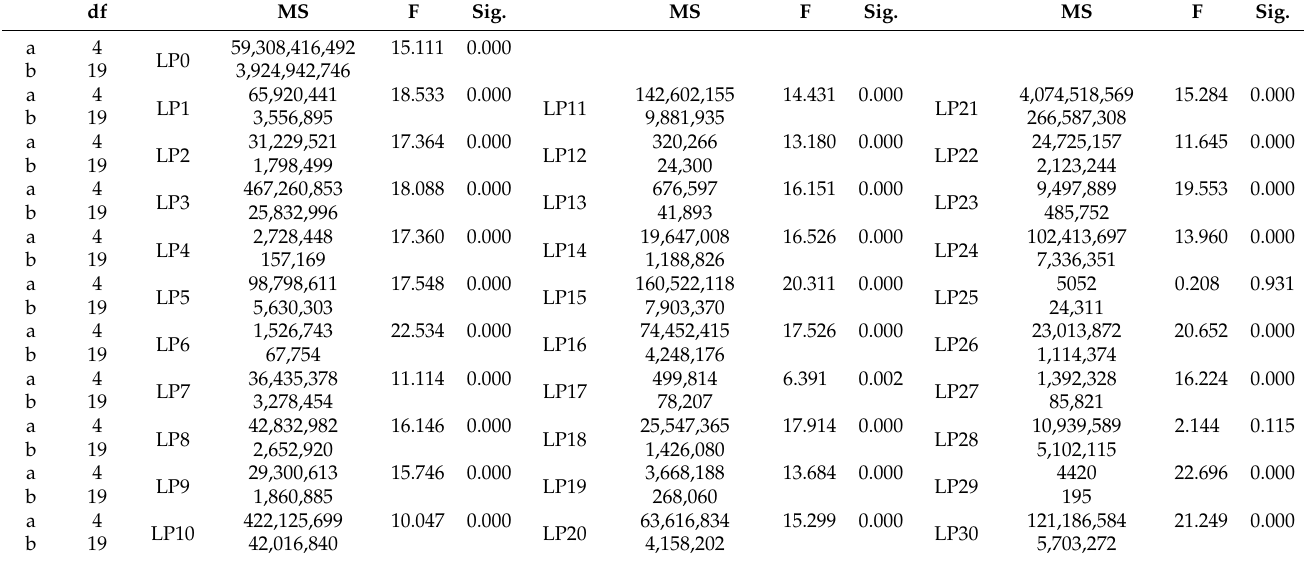
Table 8. ANOVA (Labor Population).